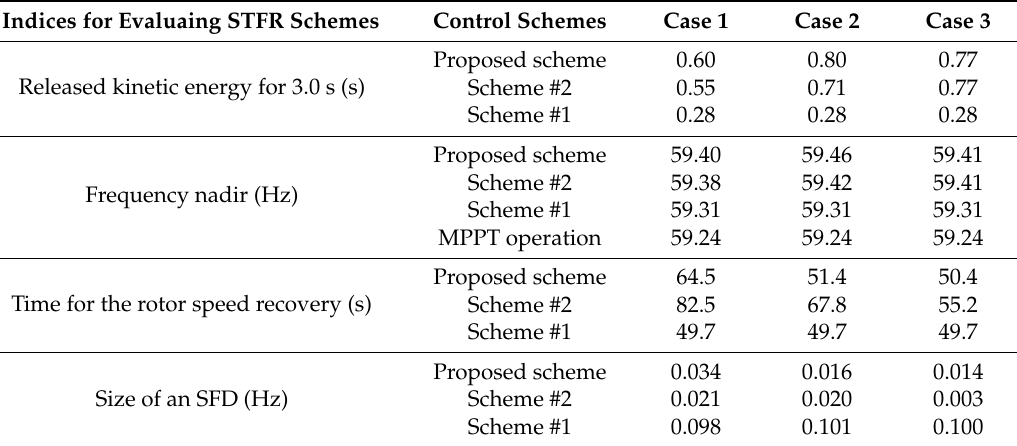
Table 4. Comparisons results for all